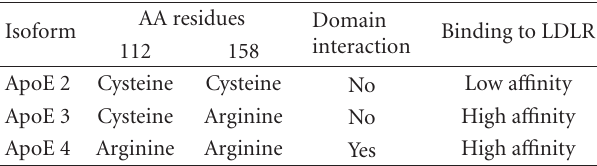
Table 1: The main di ff erences among apoE isoforms in humans. Isoform